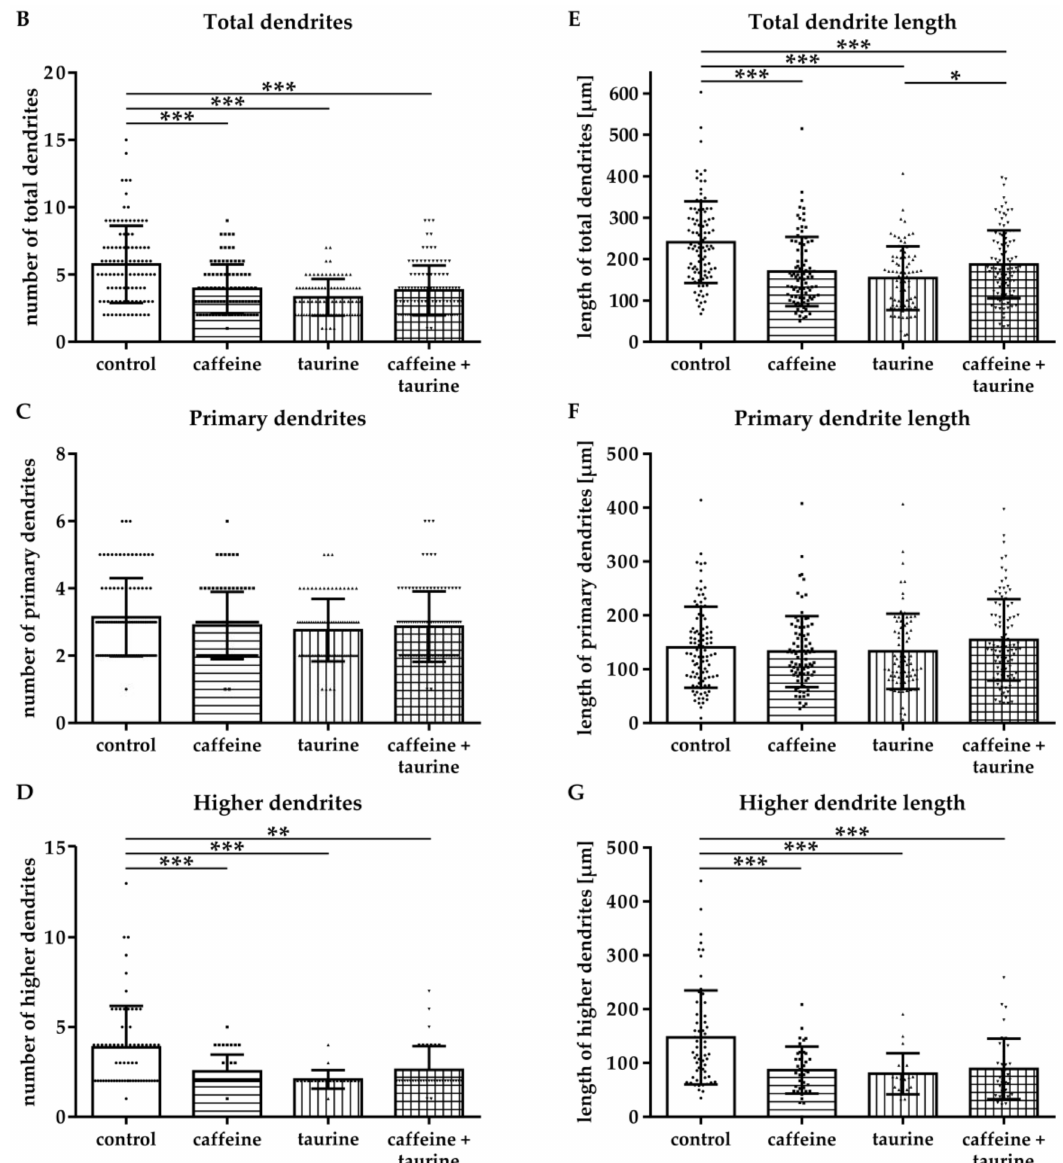
Figure 4. Ca ff eine and taurine alone or in combination reduce branching of dendrites in primary hippocampal neurons. Following three days in culture primary hippocampal neurons were incubated with or without 0.3 mg / mL ca ff eine, 4 mg / mL taurine and the combination of both for 24 h. ( A ) Dendrites were visualized by immunofluorescence staining for microtubule-associated protein 2 (Map2, green). Morphological changes were measured by defining primary dendrites ( A , bottom row, red) and higher dendrites ( A , bottom row, blue). The amount of total ( B ), primary ( C ), and higher ( D ) dendrites was quantified; subfigures ( E – G ) represent results of quantification of dendritic lengths, respectively. Data are derived from 25–30 images per group out of three independent experiments (n = 83–103 cells per group, depicted by circle = control, square = ca ff eine, triangle up = taurine, triangle down = ca ff eine + taurine). Scale bar 100 µ m. * p < 0.05, ** p < 0.01, *** p < 0.001, one-way ANOVA followed by a Bonferroni post hoc